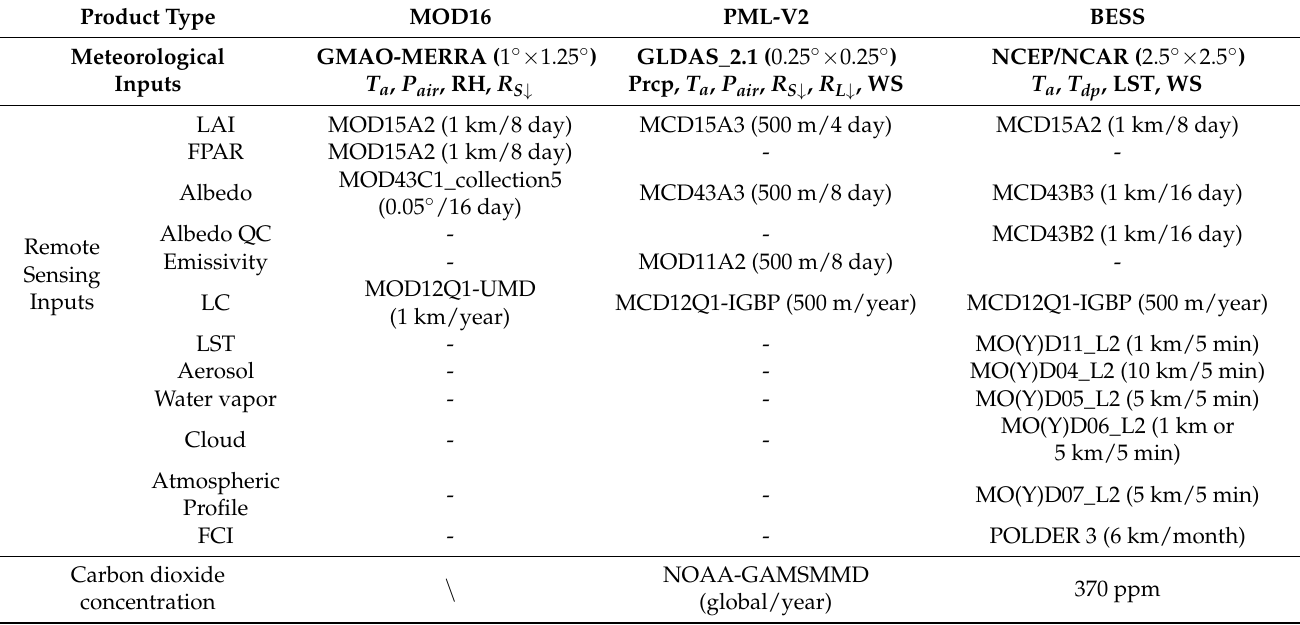
Table 6. The major input datasets of MOD16, PML-V2, and